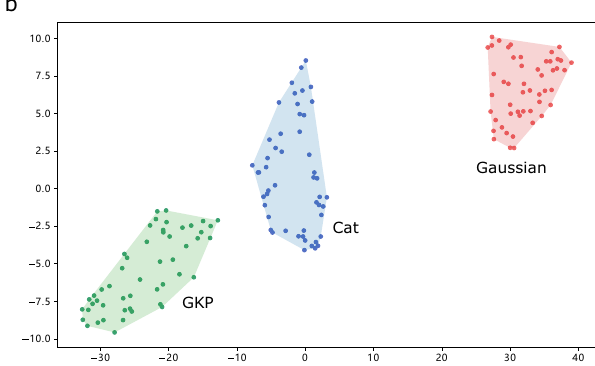
Fig. 4 | Two-dimensional embeddings of multiqubit and continuous-variable states. Sub fi gure a shows two-dimensional embeddings of state representation vectorsproduced byGQNQonIsing model(ferromagneticandantiferromagnetic) ground states, XXZ model (ferromagnetic and XY phase) ground states, locally rotated GHZ and W states. Sub fi gure b shows two-dimensional embeddings of the